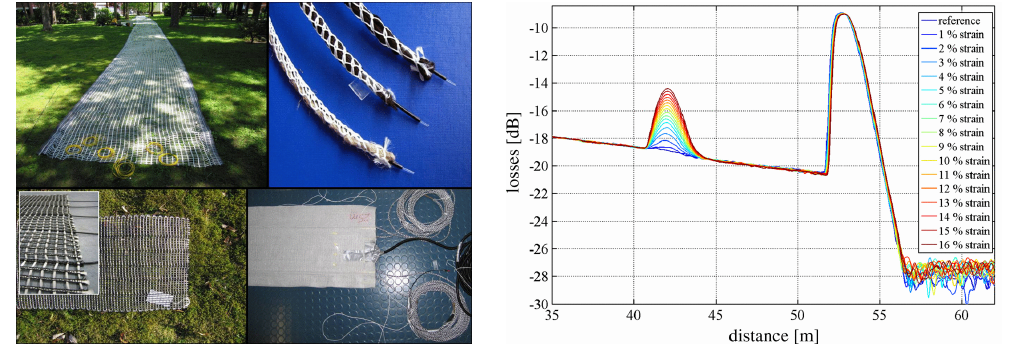
Figure 12. Left : Geotextiles (geogrids and rope-like textiles) manufactured by the Saxon Textile Research Institute with integrated polymer optical fibres (POFs). Right : ν -OTDR traces of a 50 m long POF fibre with a 1.4 m-long portion strained up to 16%. Reproduced with permission from